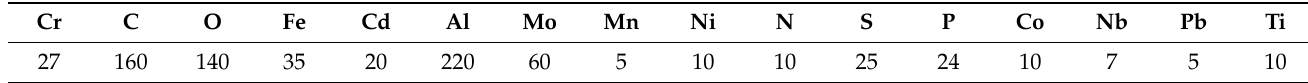
Table 3. Impurities content in V foils (ppm).